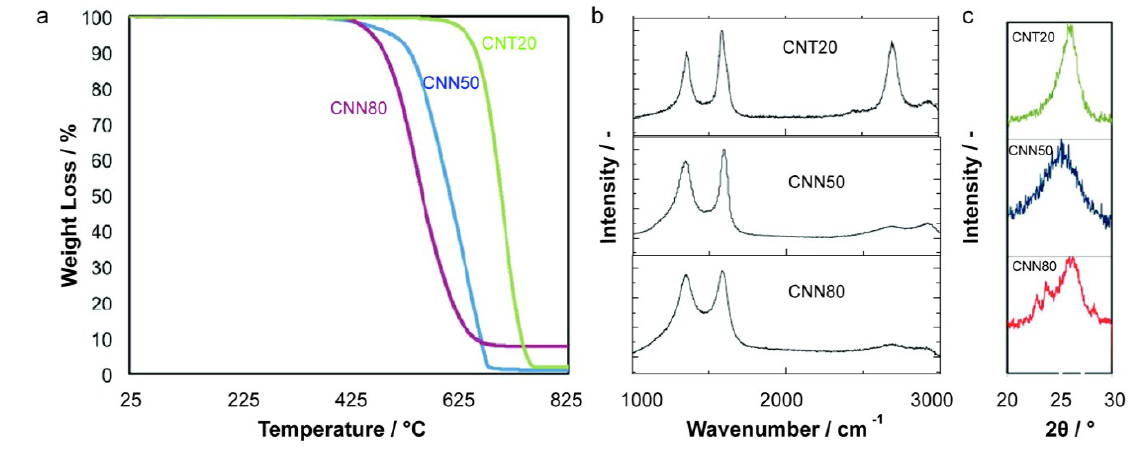
Figure 1. ( a ) TGA traces of decomposition in air; ( b ) Raman spectrum and ( c ) XRD measurements for the graphitic carbon supports.